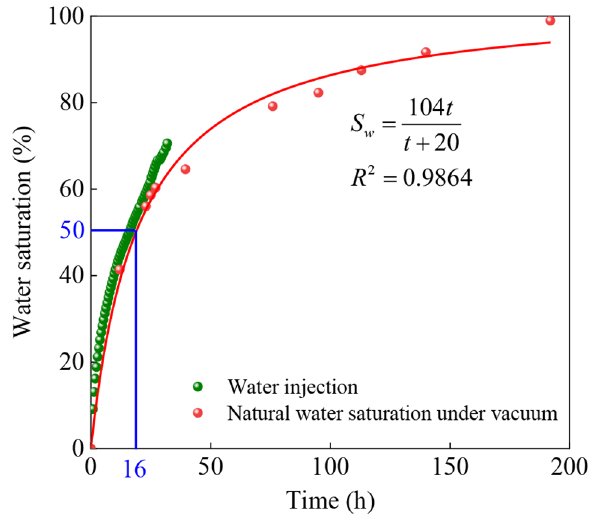
Fig. 7 Water saturation versus time under different water saturation conditions